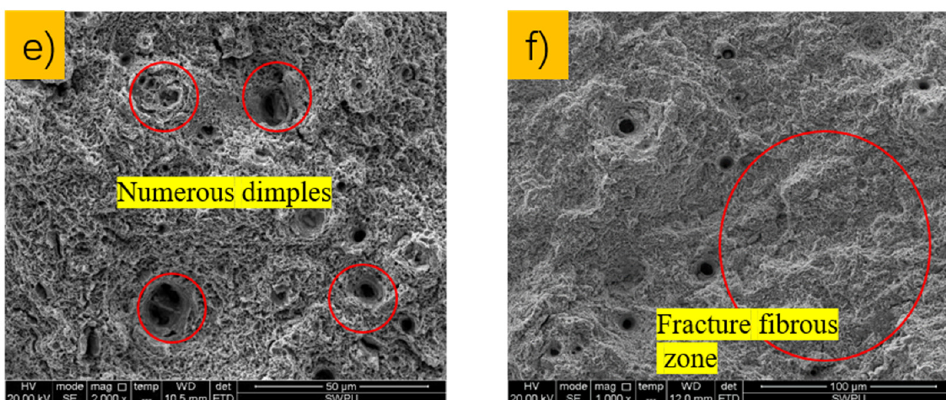
Figure 17. Tensile fracture morphology of the two steels in air at room temperature (25 °C): ( a ) C110-1 fracture with obvious shear lip and fibrous zone; ( b ) C110-2 ductile fracture with many secondary cracks; ( c ) C110-1 fracture with bigger shear lip; ( d ) C110-2 fracture with smaller shear lip; ( e ) C110-1 fracture fibrous zone of numerous dimples; ( f ) C110-2 fracture fibers.